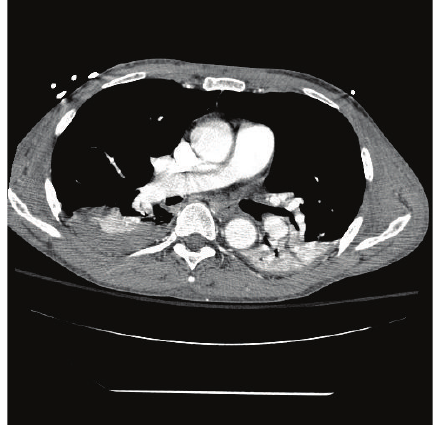
Figure 4: CT angiogram of the chest after thrombolysis and anticoagulation with resolution of visible